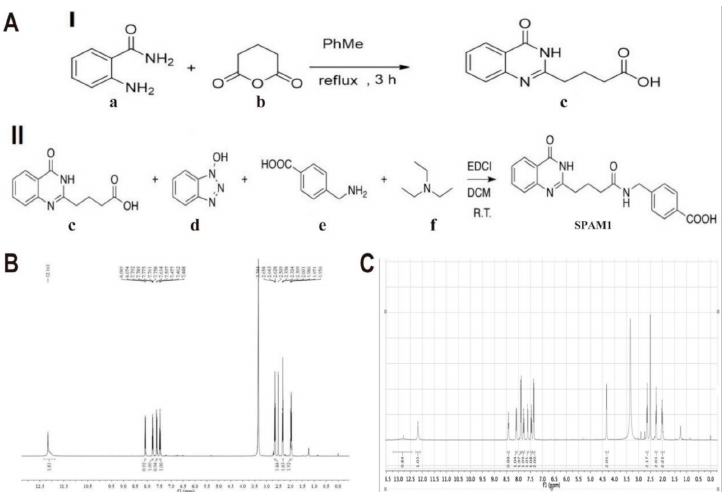
Figure 2. Synthesis process and NMR spectrum of the small molecule SPAM1. ( A ) Synthesis process of the small molecule SPAM1 (a two-step method). a: 2-aminobenzamide; b: glutaric anhydride; c: 4-(4-oxo-3,4-dihydroquinazolin-2-yl) butanoic acid; d: benzo[d][1,2,3]triazol-1-ol;